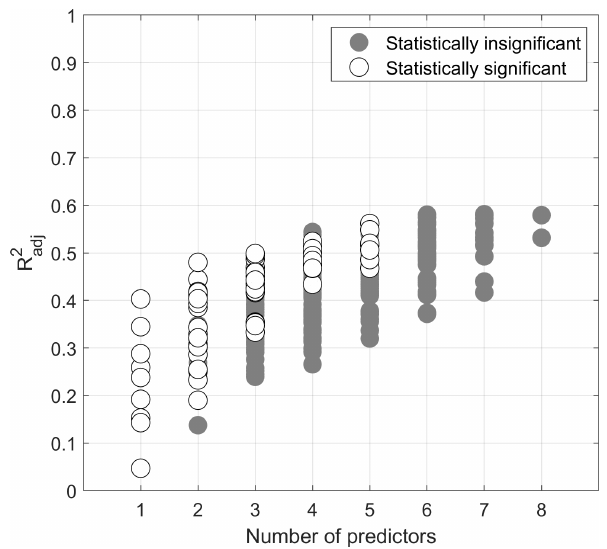
Figure 4. Plot showing which of the 383 regressions are statis- tically significant. This plot ignores the regressions that use both NSS-SO 2 − and Tot-SO 2 − 4 4